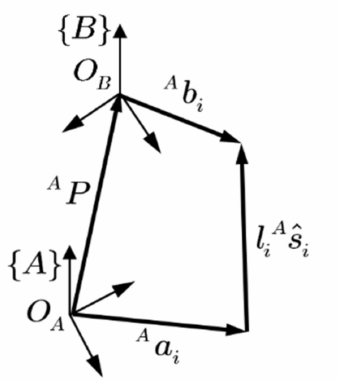
Figure 2. Vectoral closed loop of the position of the sample